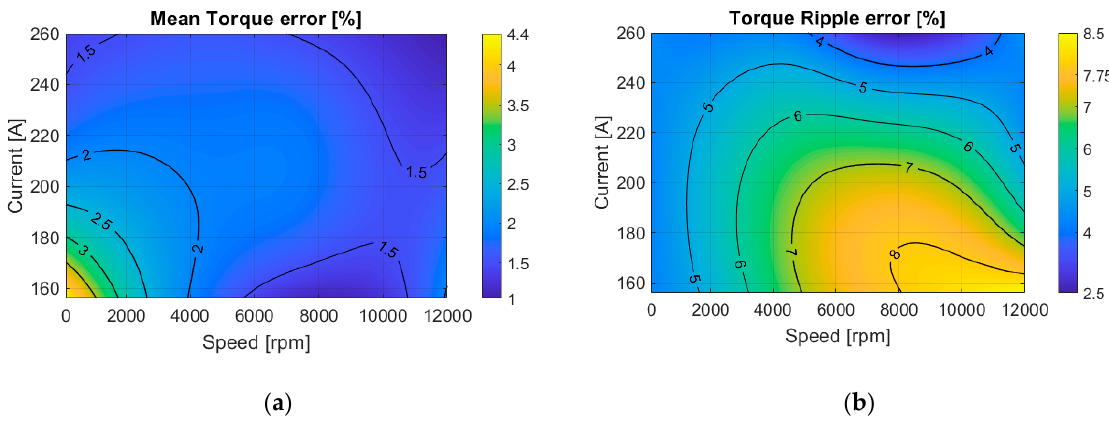
Figure 18. ( a ) Mean torque error when considering 2D FEM simulations instead of 3D ones as a function of the speed and current; ( b ) torque ripple error when considering 2D FEM simulations instead of 3D ones against the speed and current.